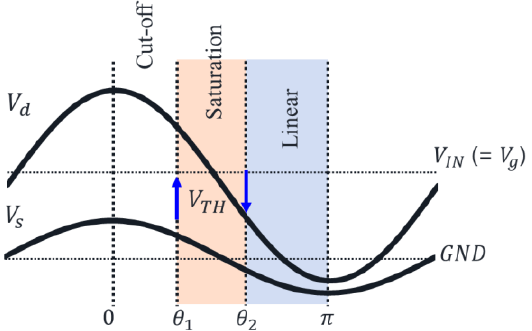
Figure 10. Waveform of Vd and Vs and operation modes in one cycle.